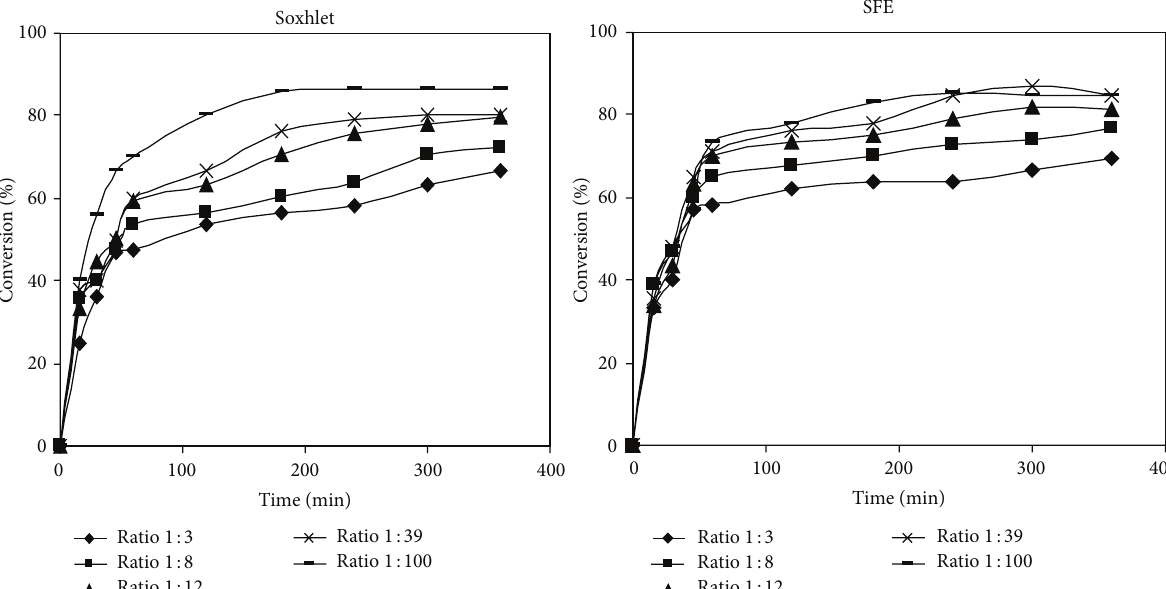
the conversion efficiency. However, as in the acid-catalysed process, the amount of methanol is excessive for ratios of 1 : 100 and 1 : 39 and the conversion in the time is similar to that achieved with a 1 : 12 volume ratio. Therefore, 1 : 12 is a suitable ratio because any increase in the ratio does not lead to any significant improvement in